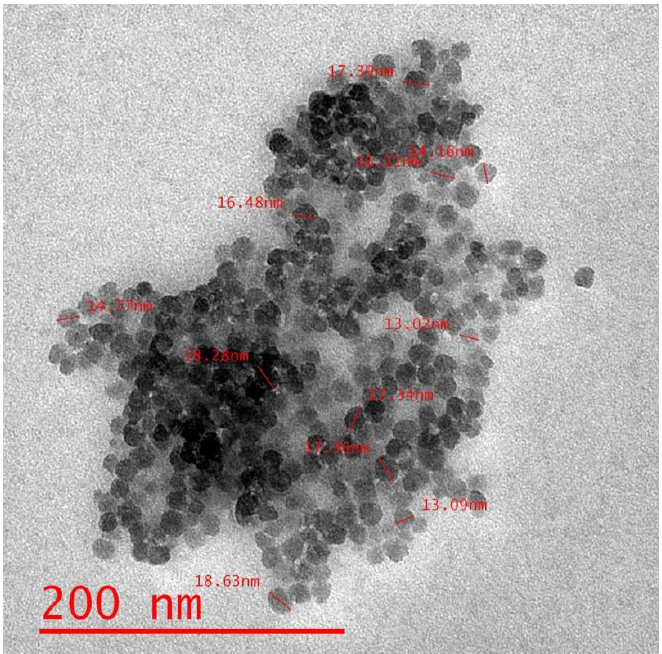
, SiO @PVP and SiO 2 2